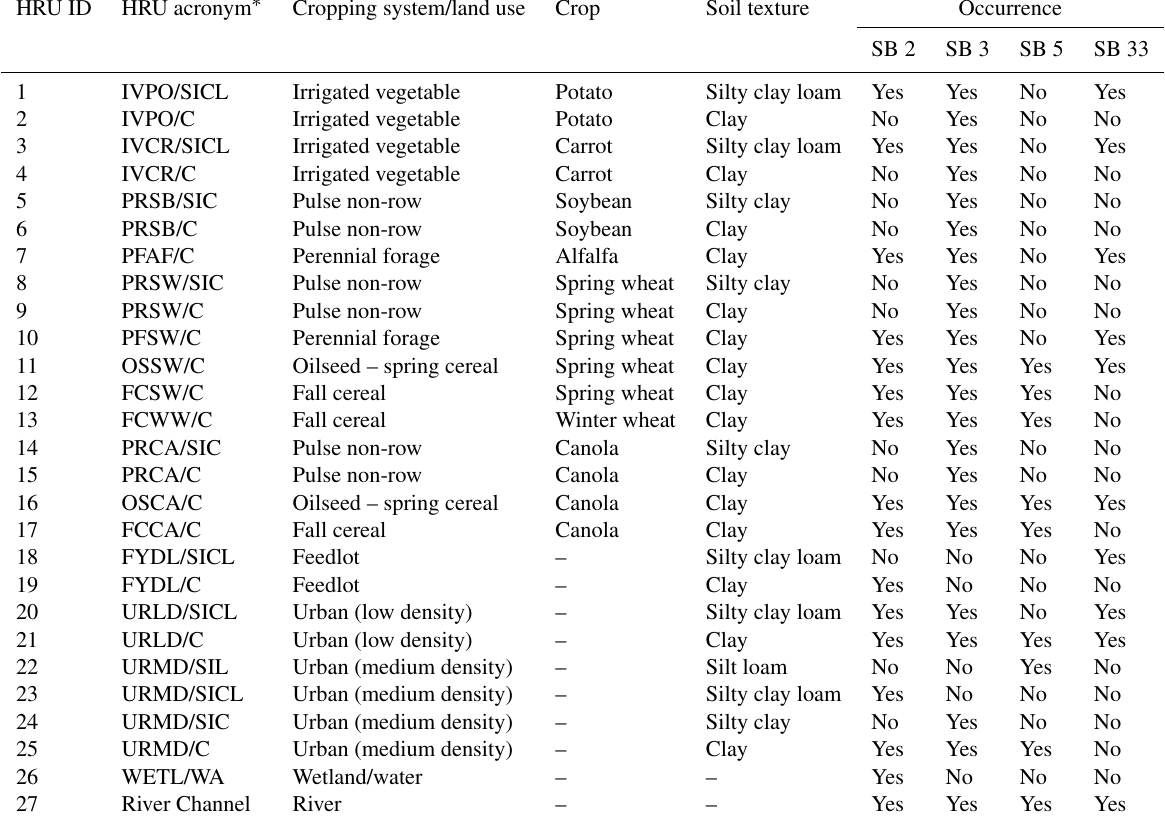
Table 1. List of hydrologic response units (HRUs) used in the LS-05OG008 watershed. HRU